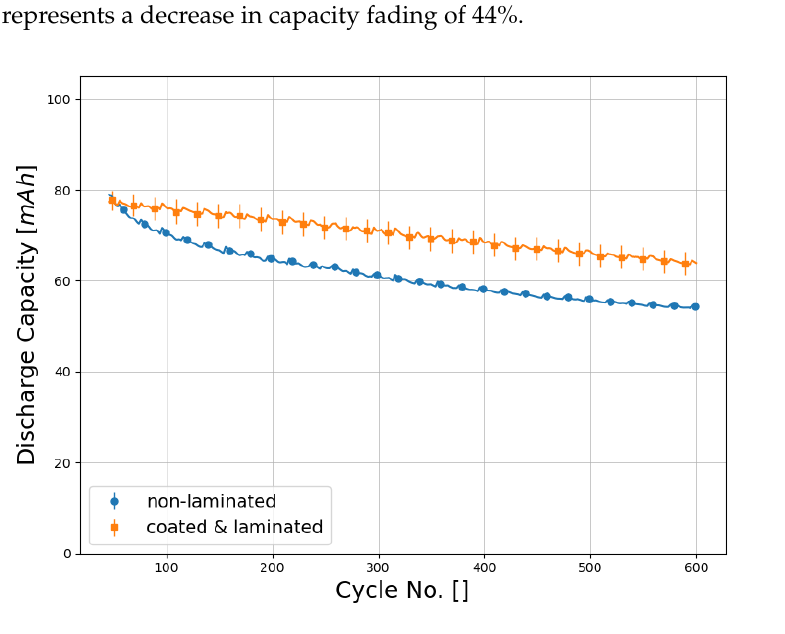
Figure 7. Results of 1 C cycling test on cells with ceramic separator. Laminated at 160 °C and with a line force of 10 N/mm; test performed after C-rate